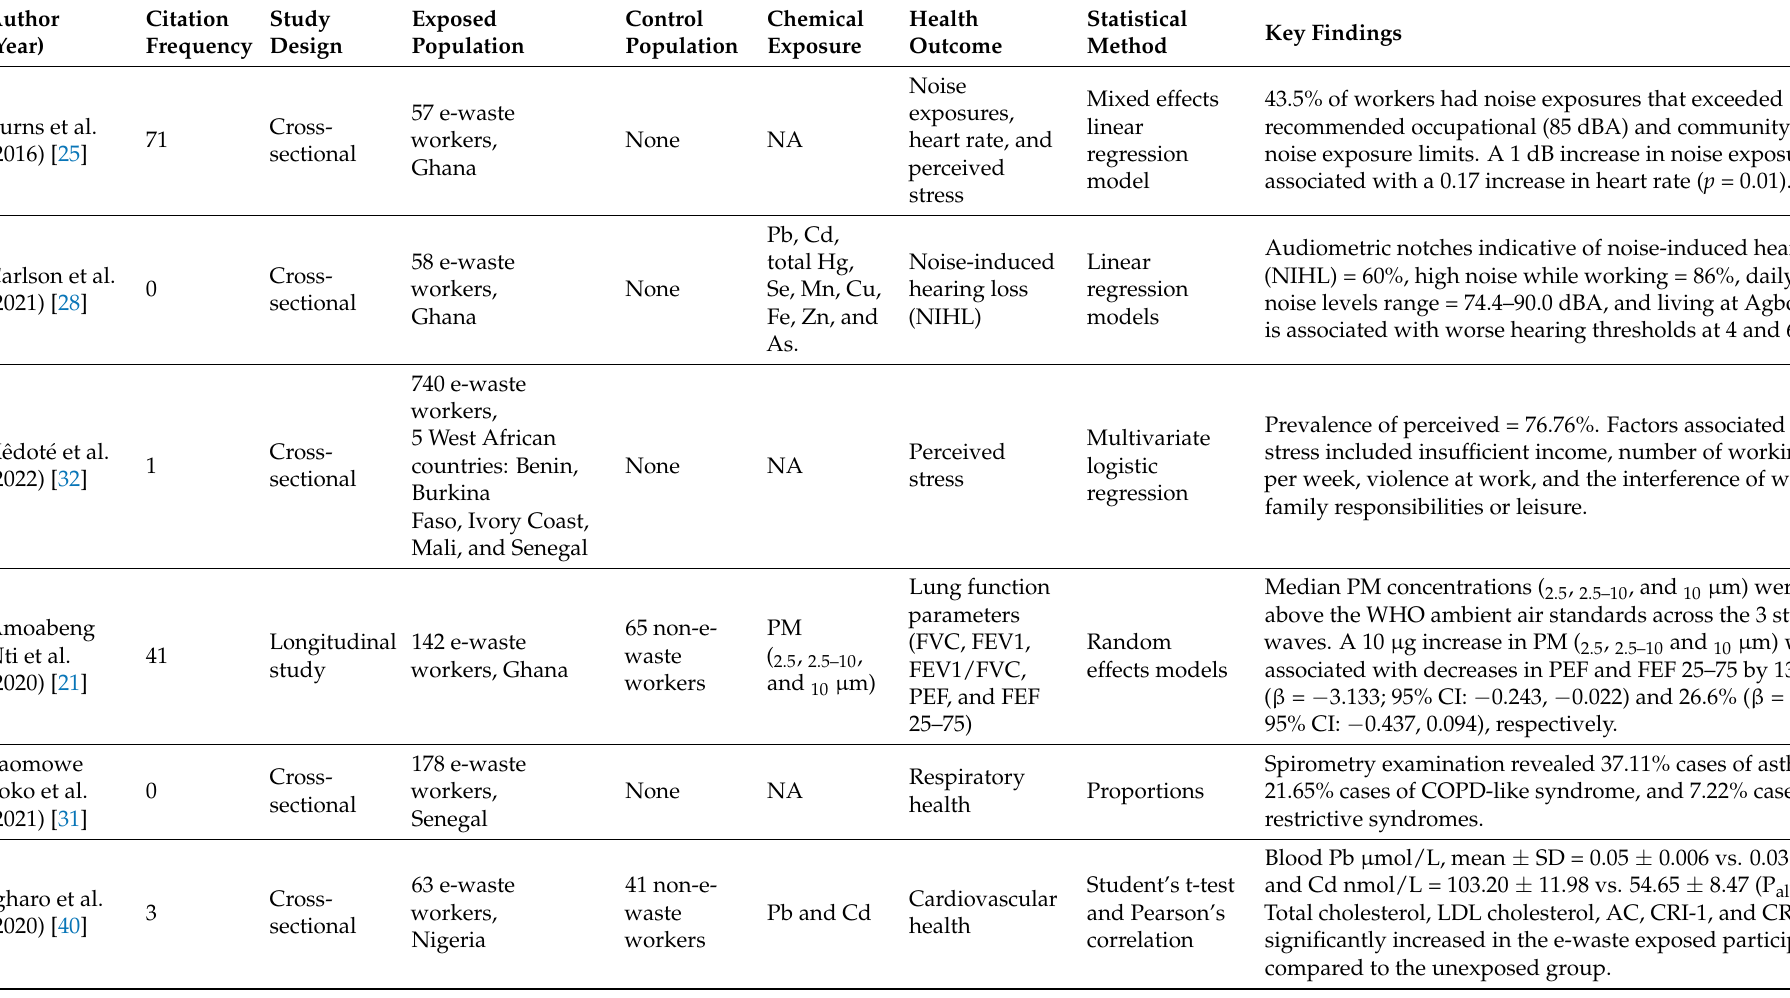
Spirometry examination revealed 37.11% cases of asthma, Proportions 21.65% cases of COPD-like syndrome, and 7.22% cases of restrictive